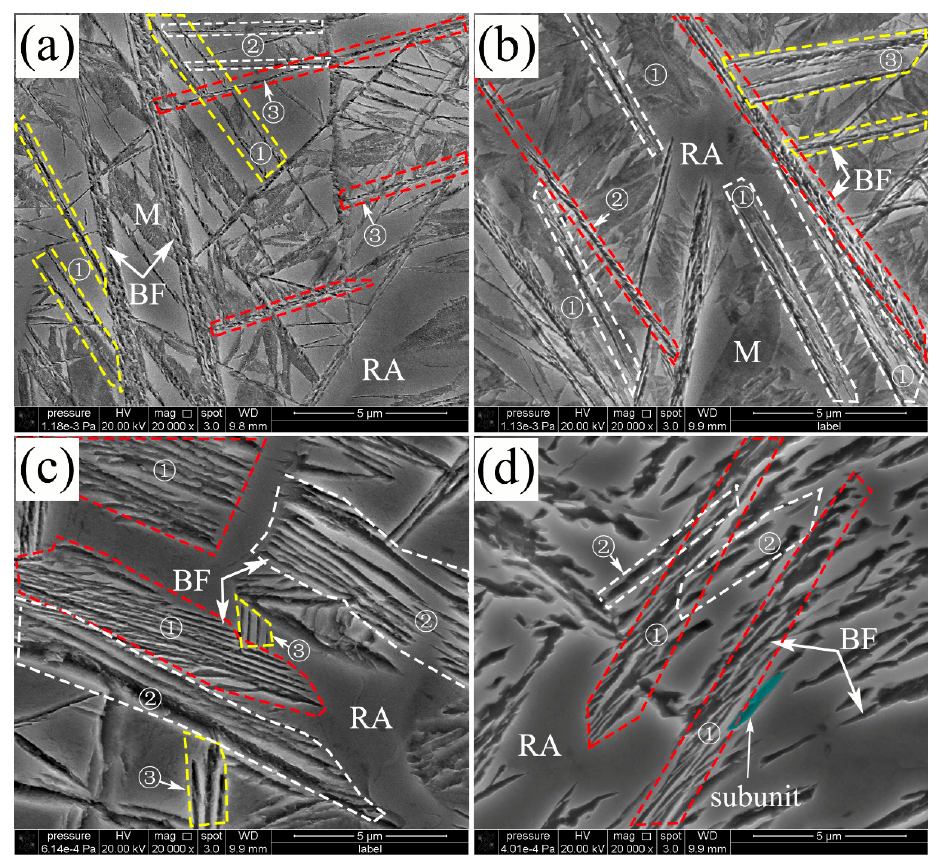
Figure 2. The propagation morphology and sheaves of the nanostructured bainite in the laser cladded coatings, transformed at ( a ) 200 °C; ( b ) 250 °C; ( c ) 300 °C and ( d ) 350 °C.